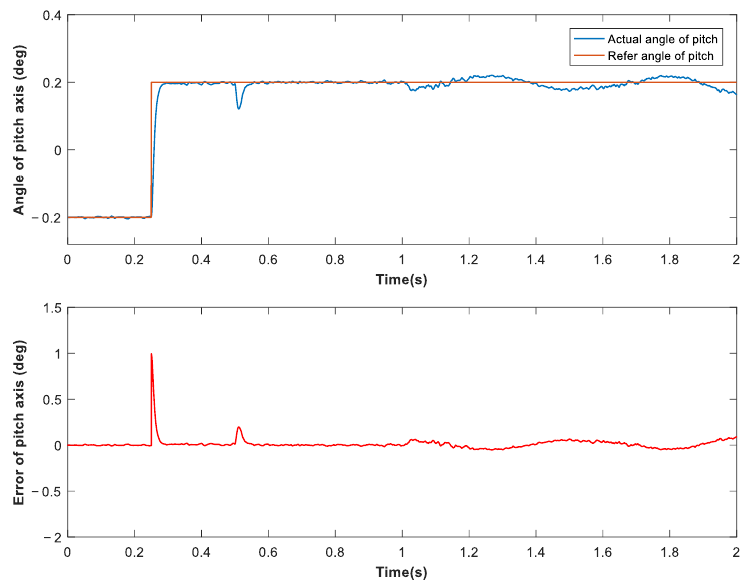
Figure 7. Response of pitch axis under CMAC – PID control.